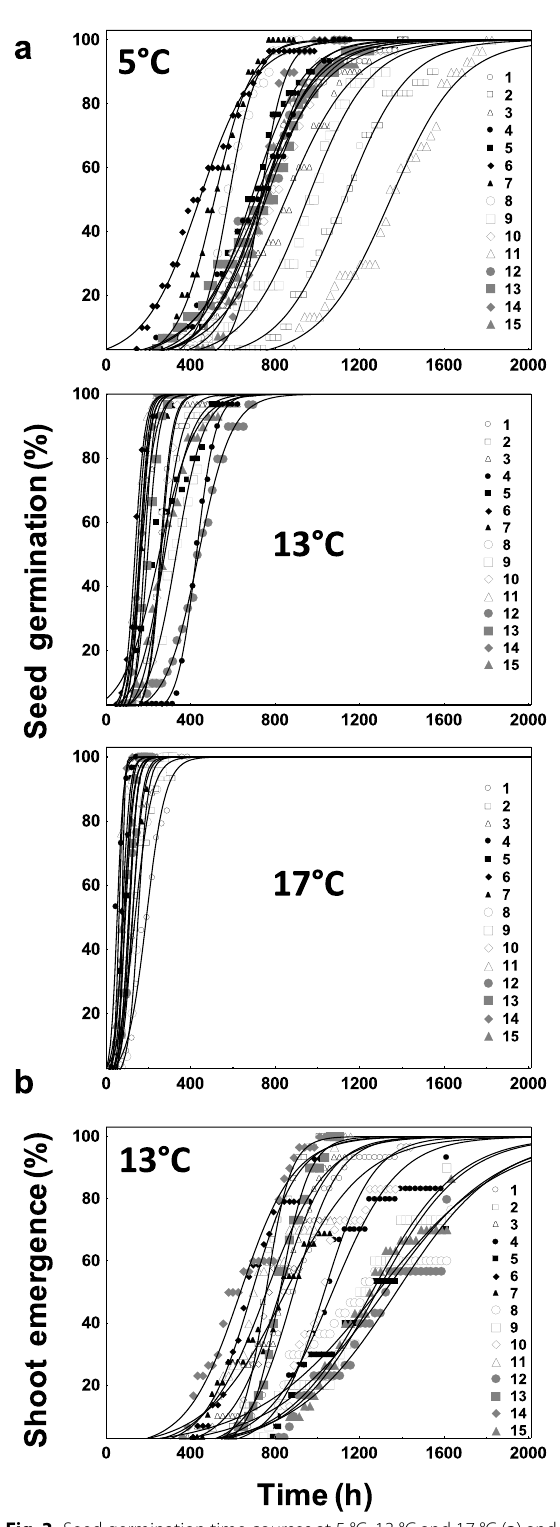
Fig. 3 Seed germination time courses at 5 °C, 13 °C and 17 °C ( a )